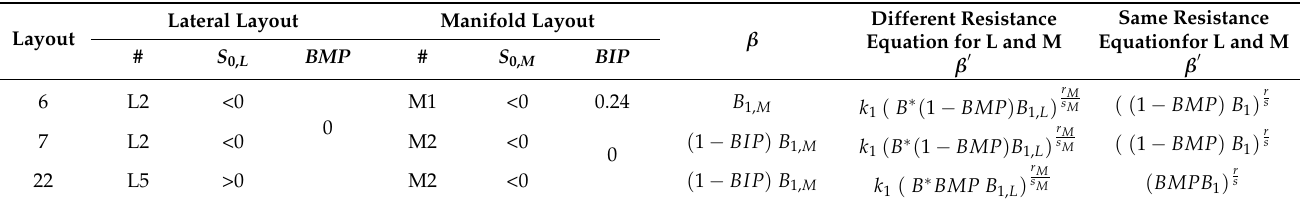
Table 3. For layouts #6, #7, and #22, considered in the IRRILAB applications, coefficients of number of rows and manifold inside diameter design relationships, β and β (cid:48) , as a function of the calibration constants, which were reported in Table 1. Rearranged with permission from ref. [29], Copyright 2020, Elsevier (Amsterdam, The Netherlands).